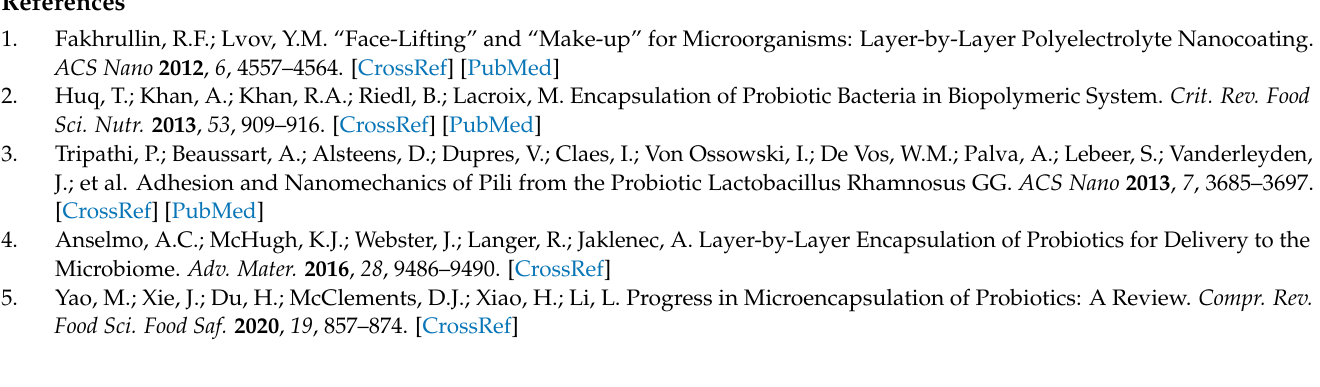
Figure S2: Confocal micrographs of optimized beads of S. boulardii under in vitro gastrointestinal gastrointestinal digestion in vitro. Table S1: Comparison of shape and dimensional parameters of S. boulardii capsules. Table S2: Comparison of internal structure parameters of S. boulardii capsules. Table S3: Comparison of internal structure parameters of S. boulardii